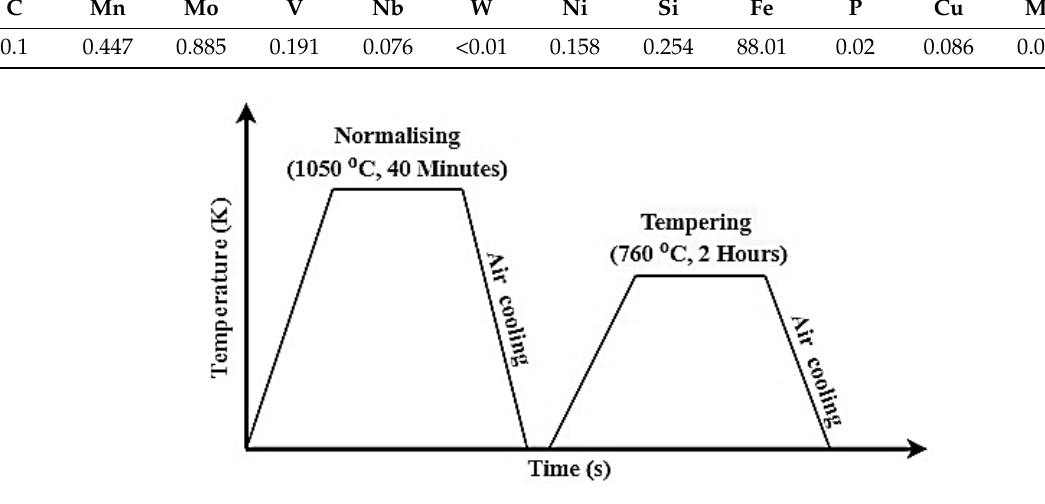
Figure 1. The heat treatment process of creep exhausted P91